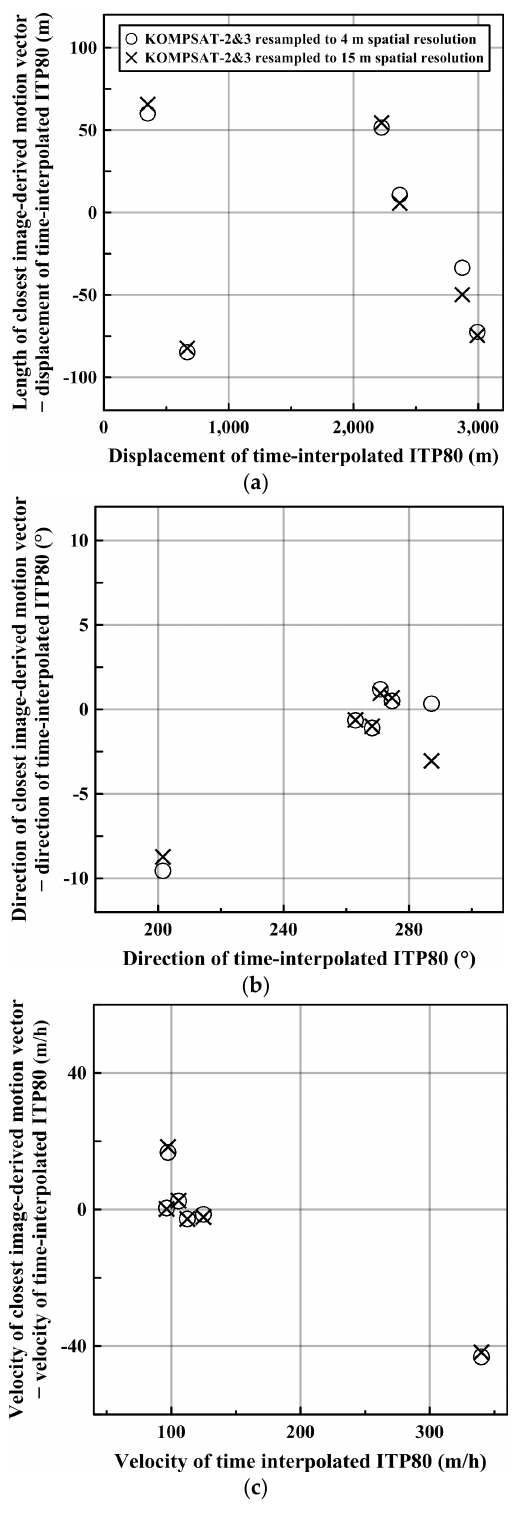
Figure 9. Comparison between sea ice drifts measured from sequential satellite image pairs and ITP80 track records: ( a ) displacements; ( b ) directions; and ( c ) velocities.